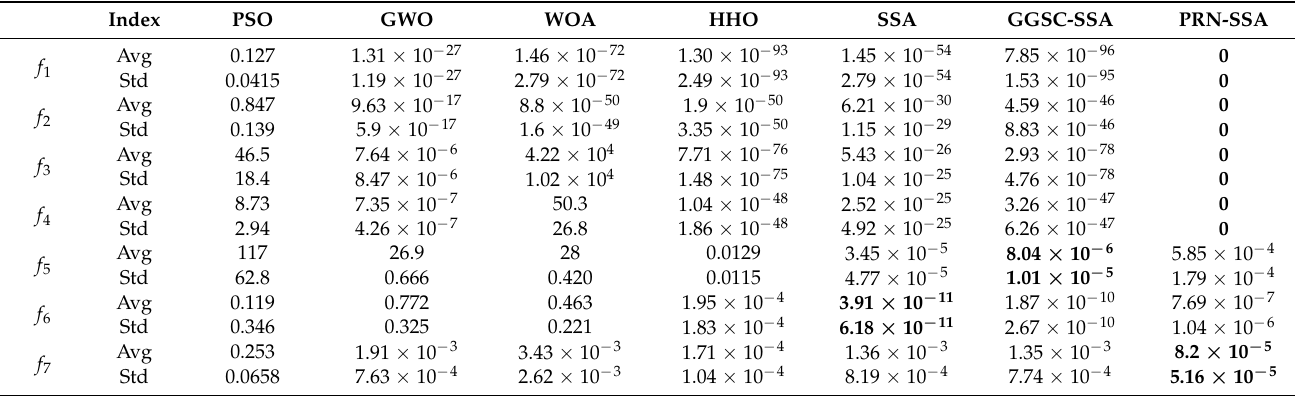
Table 4. Unimodal test